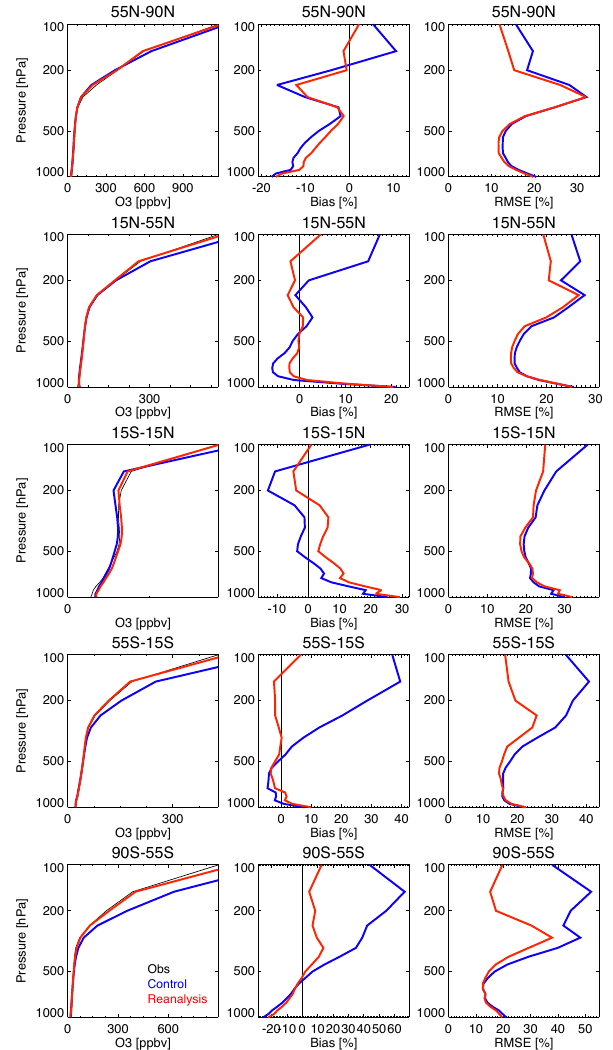
Table 1. Most of the negative bias of the model in the